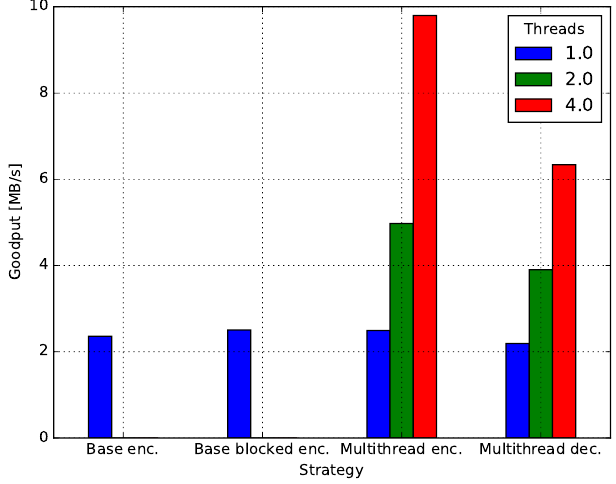
Figure 14. Encoding and decoding performance for g = 128. Block size: 128 × 128.